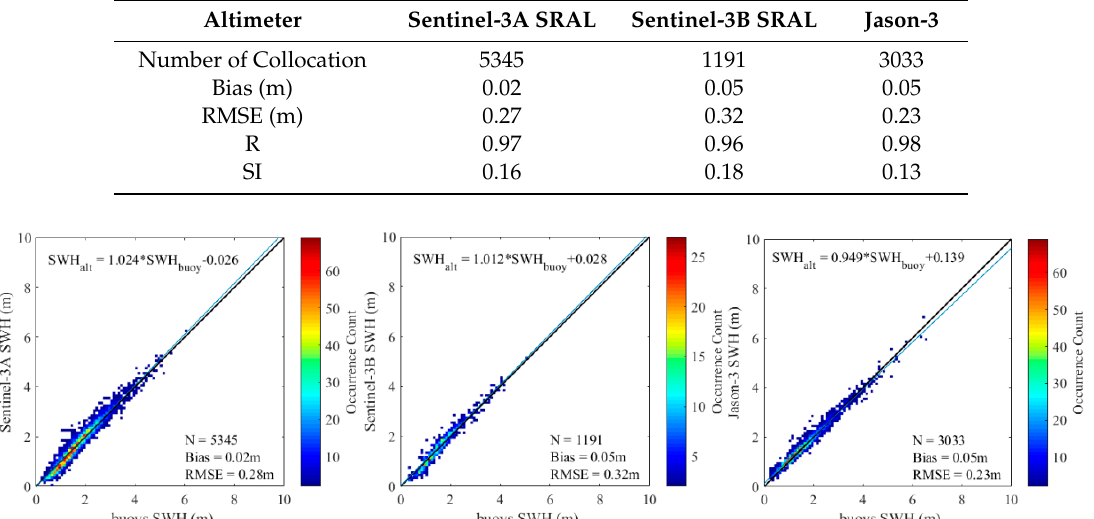
Figure 10. Comparisons of SWH between the Sentinel-3A, Sentinel-3B, and Jason-3 altimeters and the NDBC buoys.